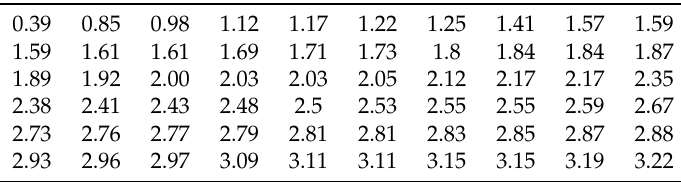
Table 10. Censored data with R = ( 20,0 ∗ 58,20 ) , T = 1.6, J = 11.